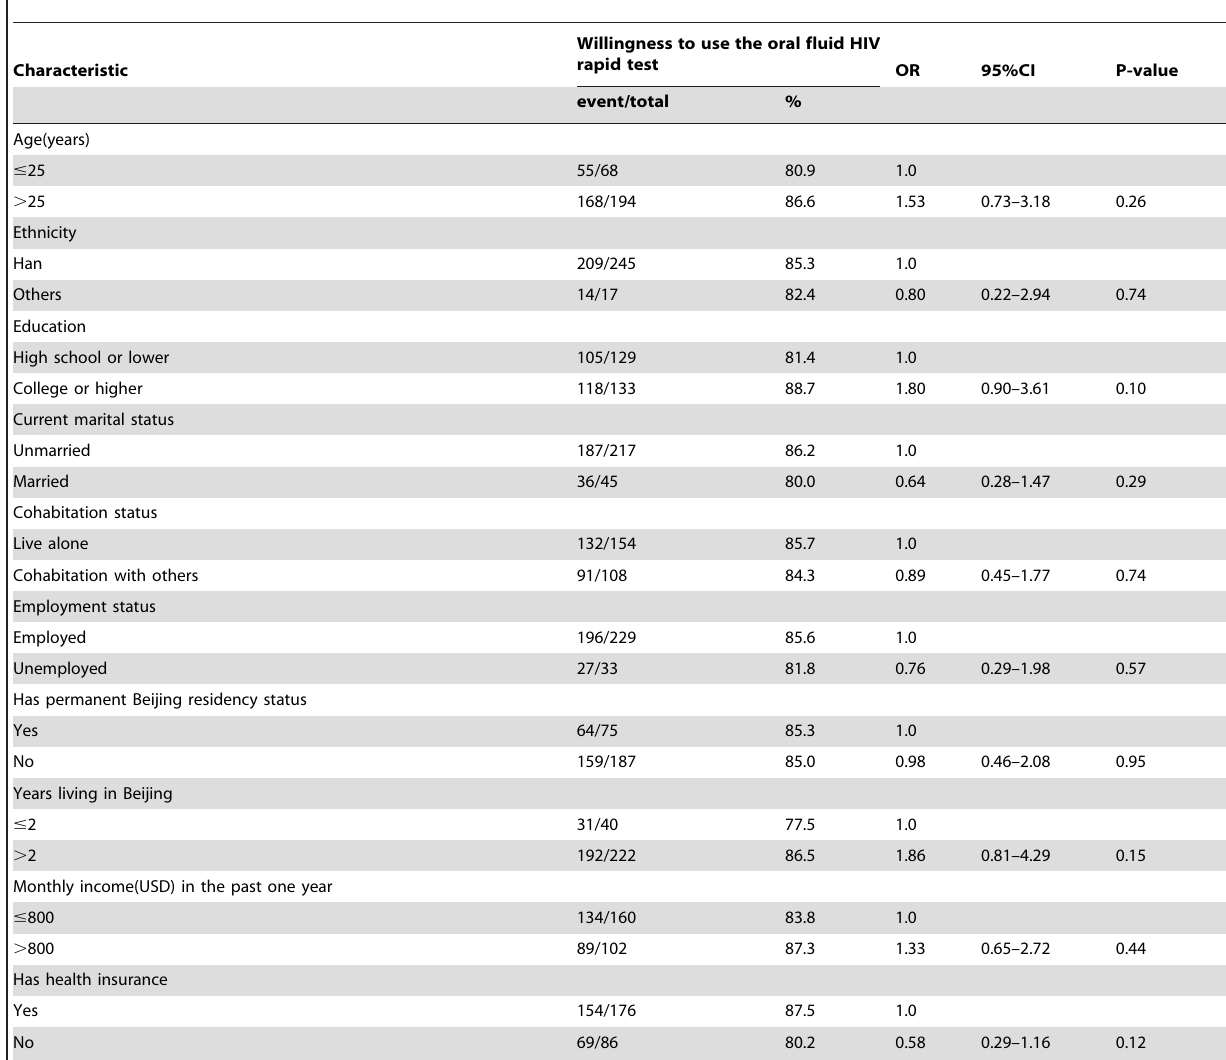
Table 1. Associations between willingness to use the oral fluid HIV rapid test and socio-demographic characteristics, among Men who have sex with men in Beijing,